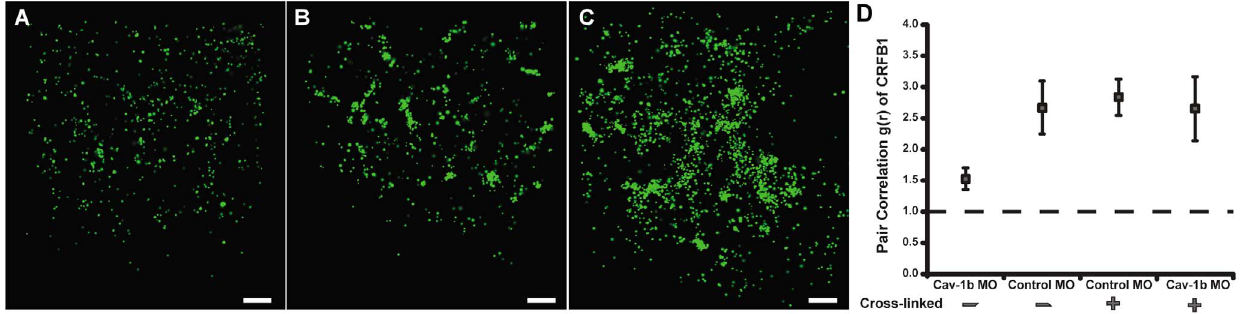
Figure 5. Crosslinking CRFB1 keeps receptor molecules clustered despite caveolin depletion. ZFL cells were co-transfected with MO and expression plasmid via nucleofection and allowed to recover/adhere to cell culture plates for , 6 hr prior to addition of crosslinking reagent. The crosslinking reaction was performed according to the manufacturer’s procedures. Cells were subsequently replenished with media and returned to the incubator for 24 hr post crosslinking. Scale bars, 1 m m. A) Cells transfected with Cav-1b MO/CRFB1 without crosslinking treatment show dispersed receptor molecules. B) Cells transfected with Control MO/CRFB1 with crosslinking clearly show clustered receptor molecules. C) Cells transfected with Cav-1b MO/CRFB1 with crosslinking. This demonstrates that despite depletion of Cav-1b, receptor molecules remain clustered. D) Pair correlation analysis confirms that with crosslinking, CRFB1 remains clustered despite Cav-1b depletion. Values of g(r) in cells with Cav-1b KD are similar to that for Controls (n $ 8 cells per